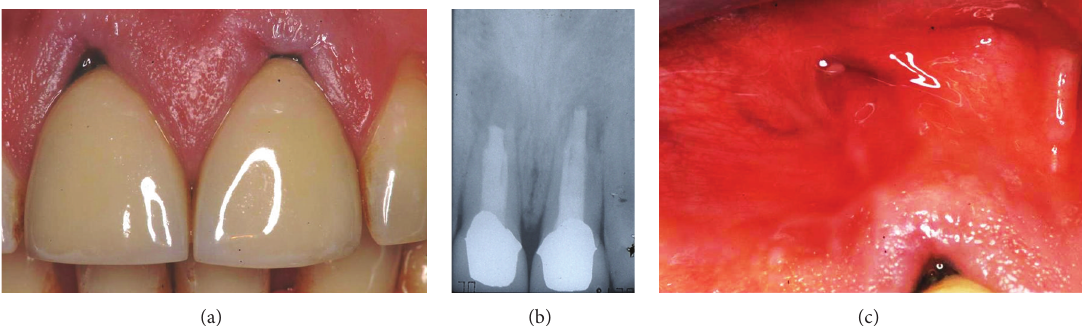
Figure 1: Radiographic (a) and clinical control (b) with the presence of a secreting fistula in correspondence with the mucosa in the apical area of 1.1 (c).